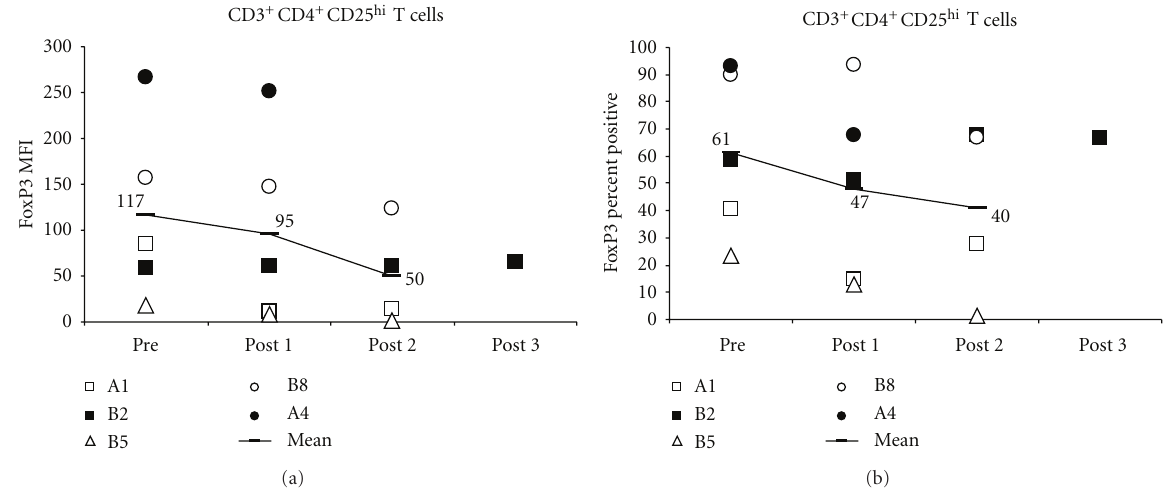
Figure 2: FOXP3 expression in CD4 + CD3 + CD25 hi (Treg) cells. Phenotyping of Treg cells from patients who received the pep/DC vaccine, showing longitudinal changes. “Pre” denotes PBMC from time point 0. “Post” denotes PBMC from postvaccine administration at time points available. Patient A1 tested at days 35 and 56; pt B2 at d28, 56, and 112; pt B5 at d14 and 28; pt B8 and d14 and 112, pt A4 at d14. (a) FOXP3 assessed intracellularly in CD3 + CD4 + CD25 hi cells, showing MFI, or (b) % positivity. One-tail t -test P values are: FOXP3 MFI: pre to post 1: 0.09, pre to post 2: 0.07, post 1 to post 2: 0.17; all other values higher and n.s. FOXP3 percent positive: pre to post 1: 0.03; pre to post 2: 0.10; all other values higher and